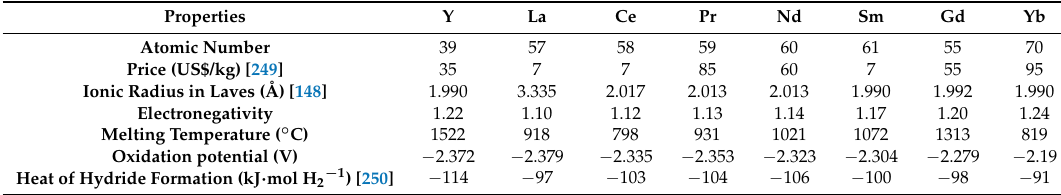
Table 7. Properties of some REs used as additives in AB 2 MH alloys.